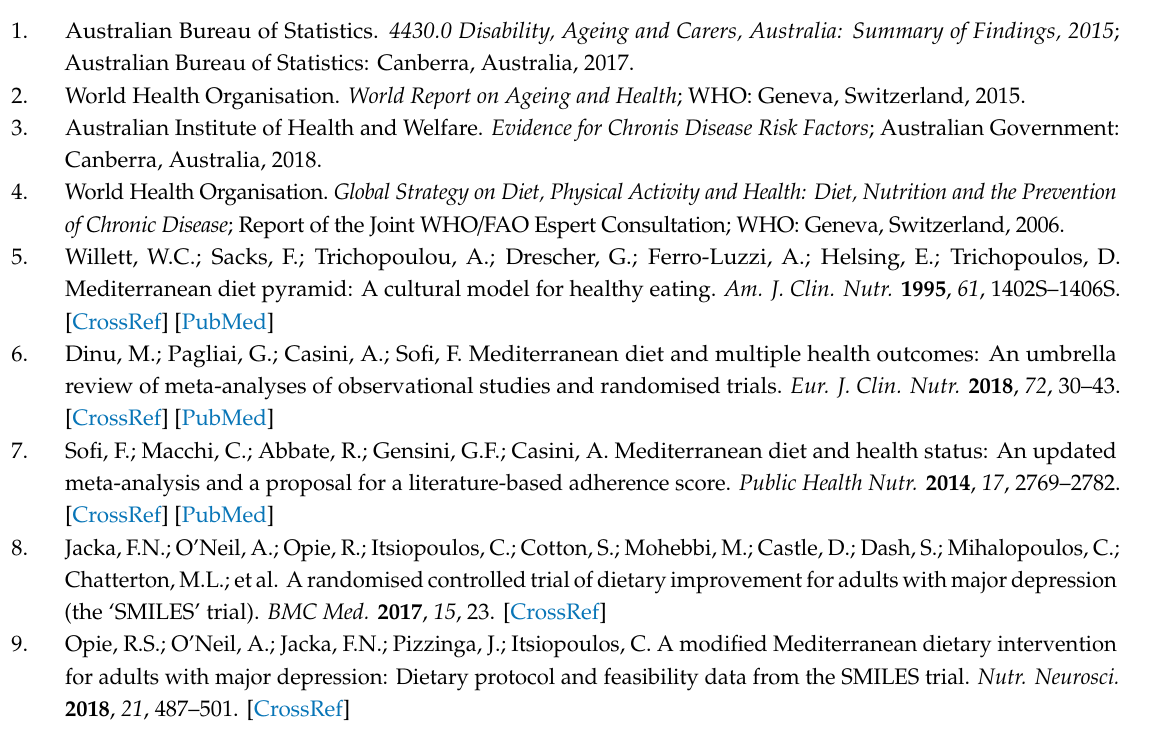
Table S1: Text messages and COM-B model for behaviour change. Table S2: Phase 2 participant characteristics. Figure S1. Participants ( n = 17) Consumer research group opinions on program food palatability and confidence in food access and preparation